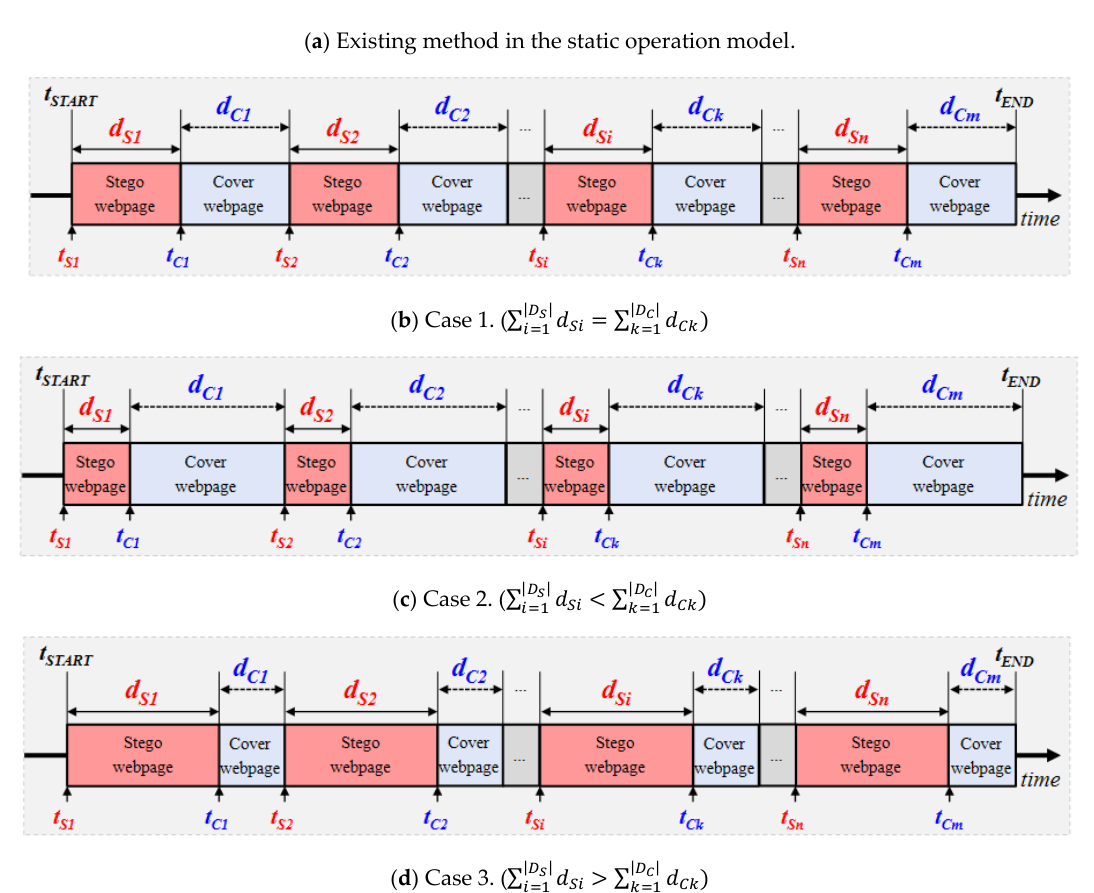
Figure 14. Concept to measure undetectability.